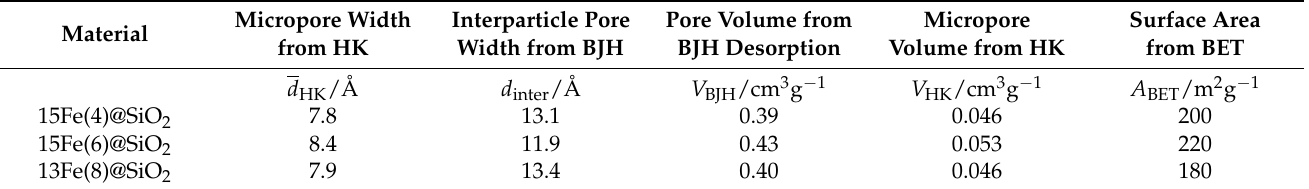
Figure 1. Results of N 2 -physisorption experiments. ( A ) Adsorption (filled symbols) and desorption (open symbols) isotherms of as-made Fe@SiO 2 core-shell particles: (a) 13Fe(8)@SiO 2 , (b) 15Fe(6)@SiO 2 , (c) 15Fe(4)@SiO 2 , and ( B ) pore width distribution for the corresponding micropore regime (insert left) using the Harvardt-Kawazoe (HK) method. Table 1. Results of N 2 -physisorption experiments. The average micropore width d HK and micropore volume V HK calculated via the Harvardt-Kawazoe (HK) method, interparticle pore width d inter , and pore volume V BJH calculated via Barrett-Joyner-Halenda (BJH) method, and a specific surface area A BET calculated via the Brunauer-Emmet-Teller (BET) method for different core-shell materials.